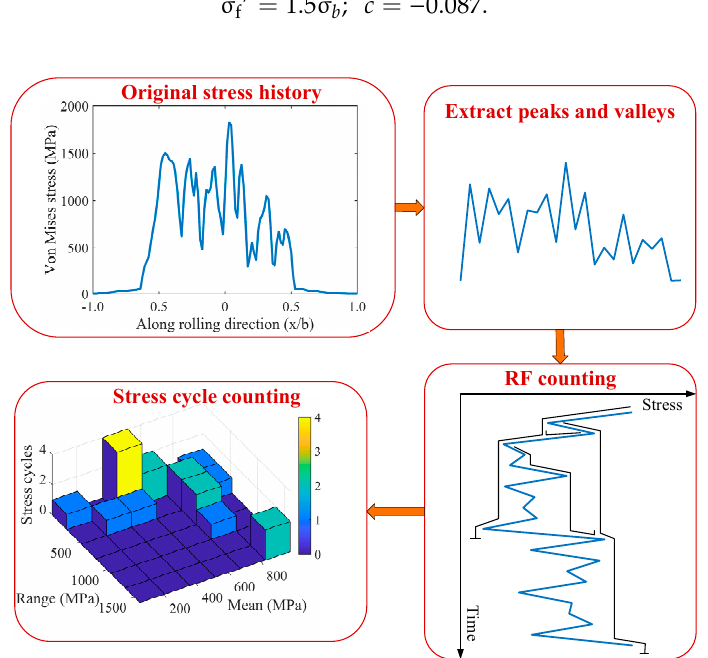
Figure 3. The rainflow method flowchart of stress cycle counting.